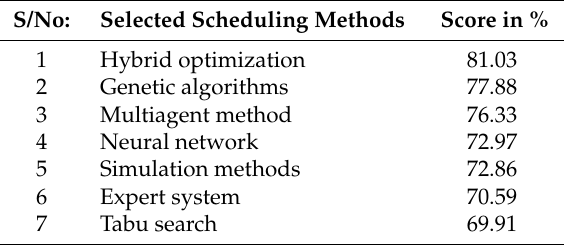
Table 8. Best scheduling alternatives based on AHP analysis.